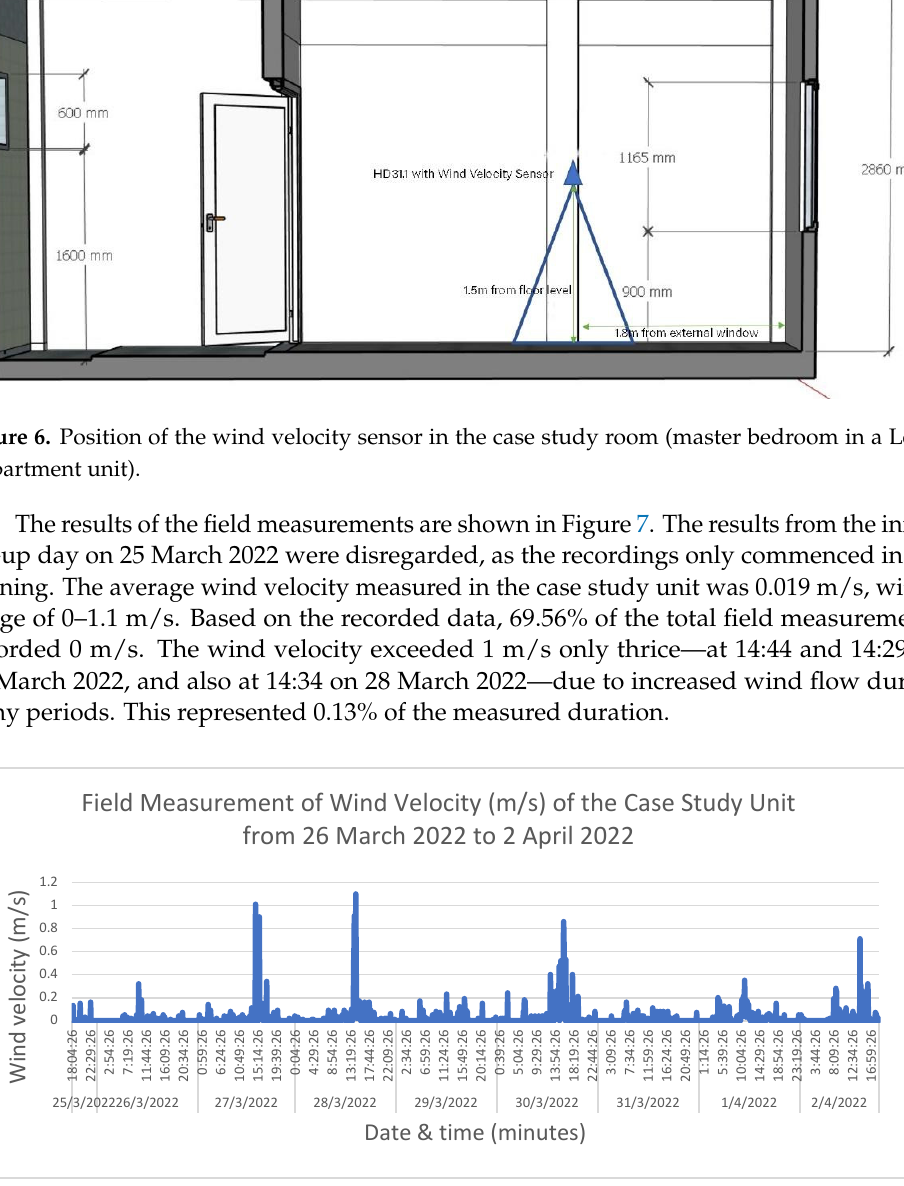
Figure 5. AP471S wind velocity hotwire airspeed probes [14] ( left ), and setup of field measurements ( right ).